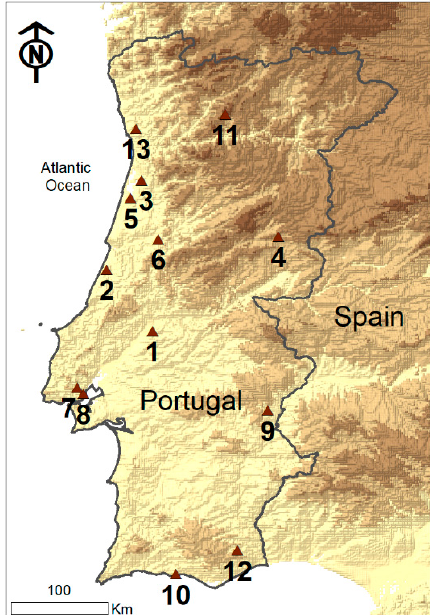
Figure 1. Location of the air quality monitoring stations. Table 1. Air quality data information (Monitoring stations’ Id, altitude and location) and basic statistics of pollutants.